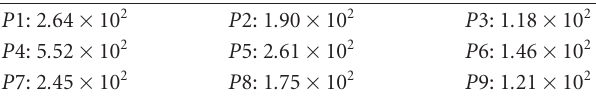
Table 5: The average value of luminance of no-lens nine-spot meas- urement (unit: cd/m 2 ).